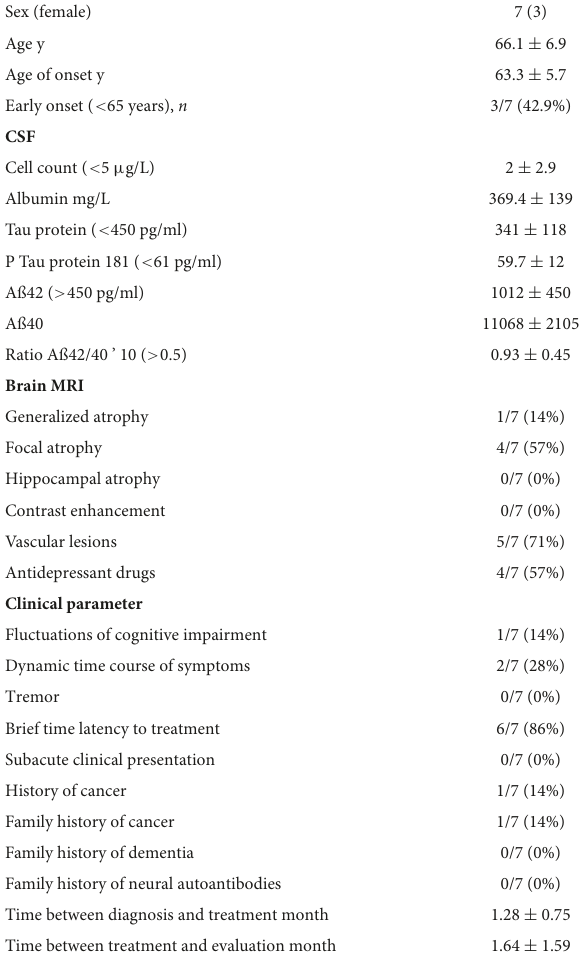
TABLE 1 Demographic and clinical patient